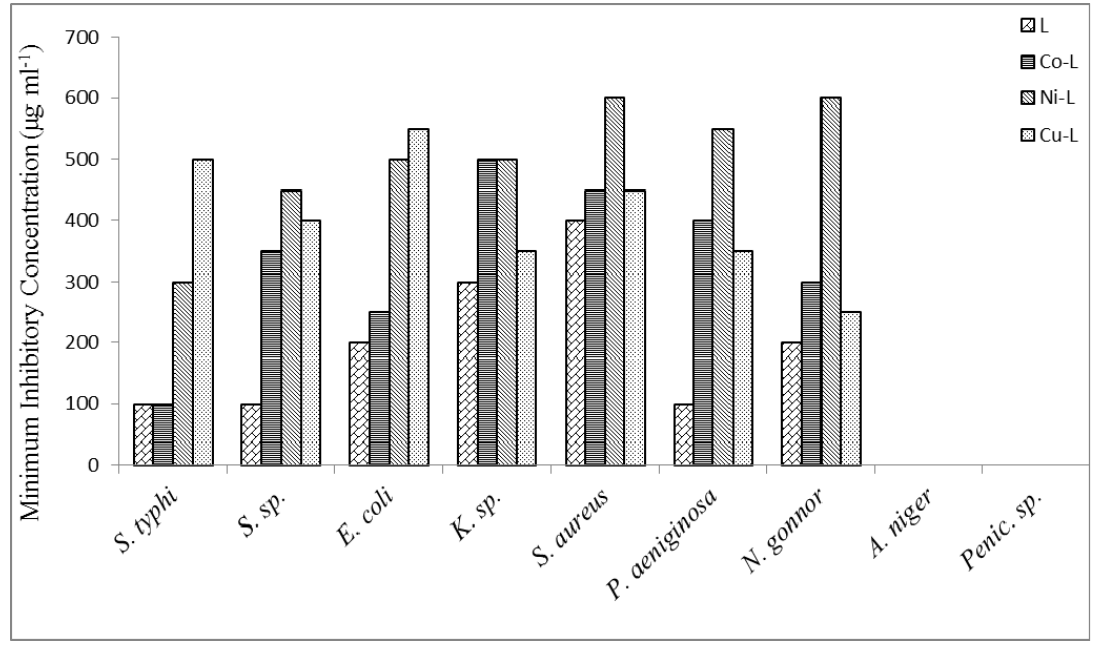
Figure 2. Minimum inhibition concentration of the ligand and metal complexes against some